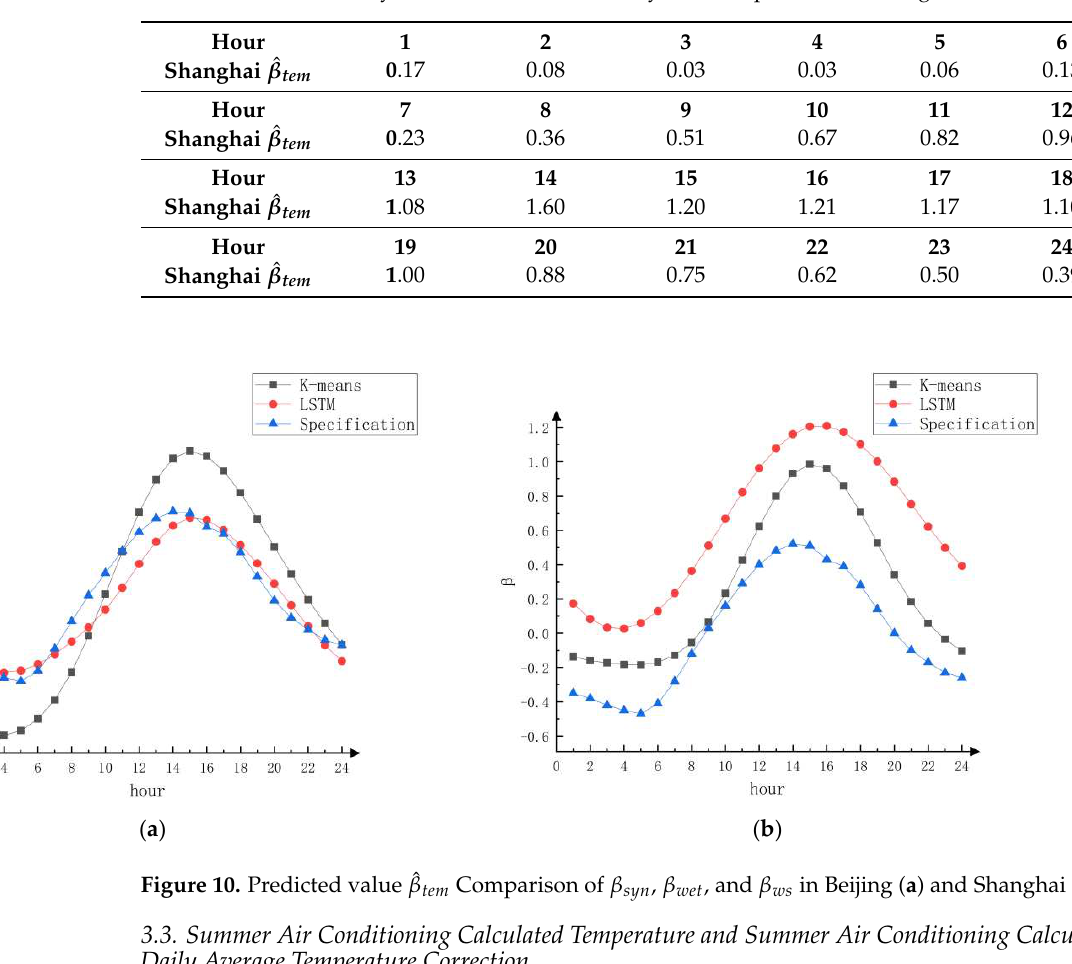
Table 8. Predicted hourly variation coefficient of dry bulb temperature in Shanghai.